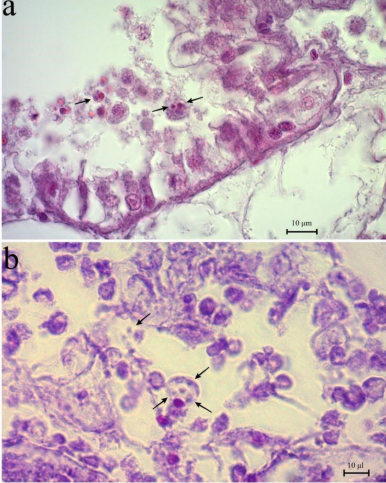
Figure 3. ( a ) Histological section of Ostrea edulis ; Bonamia -like parasite in necrotic tissue of diges- tive gland ( b ) Gonadal connective tissue cells infected with Bonamia -like parasite. H&E staining, 1000 ×